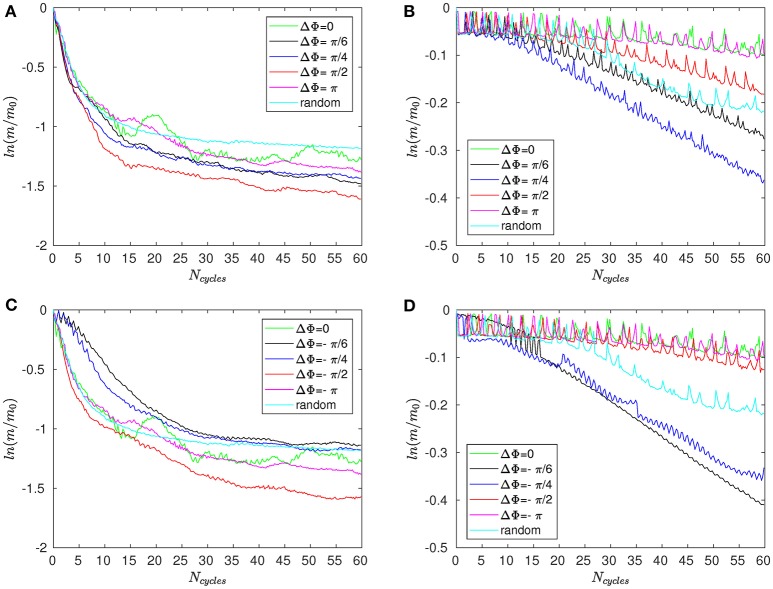
Logarithm of the mixing number, ln(m/m0), as a function of the number of cycles Ncycles for Re = 5.10−2 and for different phase lags ΔΦ corresponding to antiplectic MCW in (A) the PCL region (area 1); and (B) above the mucus–PCL interface (area 2). (C,D) are similar to (A,B), but for symplectic MCW.